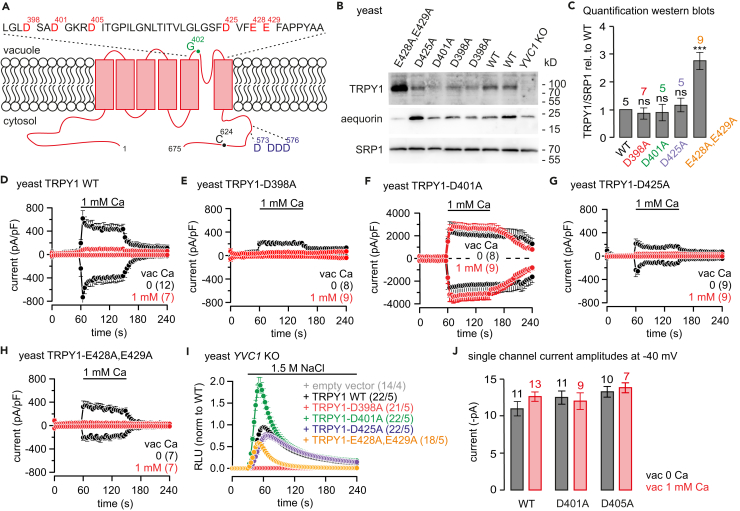
Vacuolar TRPY1 Currents in YVC1 KO Yeast Expressing Wild-Type or Mutant YVC1 cDNAs(A) Predicted transmembrane topology of the yeast vacuolar TRPY1 (675 amino acid residues) with negative charge cluster at the cytosolic C-terminus assumed to be responsible for TRPY1 activation (blue) (Su et al., 2009) and negatively charged residues within the S5-S6 linker facing the vacuolar lumen (red). The TRPY1G402S mutant (green) is constitutively active (Zhou et al., 2007), and the TRPY1C624S mutant (black) can no longer be activated by 2-mercaptoethanol (Hamamoto et al., 2018).(B) Western blot of protein lysates from non-transformed yeast (YVC1 KO) or YVC1 KO yeast transformed with wild-type (WT) and mutant YVC1 cDNAs (as indicated). Filter was stripped and incubated with antibodies for aequorin (middle) and SRP1 (serine-rich protein; bottom) as controls.(C) Antibody stain intensities of TRPY1 proteins in (B) were quantified relative to the antibody stain of the endogenous serine-rich protein 1 (SRP1) and normalized to the WT TRPY1/SRP1 ratio (summary of five independent western blots). One-way analysis of variance (ANOVA): not significant (ns), ∗∗∗ p<0.001 compared to WT.(D–H) Whole-vacuole currents at −80 and 80 mV extracted from 200-ms ramps (0.5 Hz) spanning from 150 to −150 mV, Vh = 0 mV, plotted versus time, activated by cytosolic Ca2+ (1 mM) at 0 (black) or 1 mM (red) vacuolar (vac, patch pipette) Ca2+ in YVC1 KO cells expressing WT ( D) or mutant (E–H) YVC1 cDNAs.(I) Changes of cytosolic Ca2+ challenged by 1.5 M NaCl (hyperosmotic shock) monitored in transformed YVC1 KO yeast cells (as in D–H) as relative luminescence units (RLU). Bars indicate application of 1 mM Ca2+ (D–H) or 1.5 M NaCl (I).(J) Single-channel current amplitudes of TRPY1WT, TRPYD401A, and TRPY1D405A in the absence and presence of vacuolar 1 mM Ca2+, analyzed at −40 mV from current traces of voltage ramps and voltage steps in whole vacuoles and excised (outside-out) vacuolar patches. Single channels of TRPY1D405A were analyzed from yeast cells transfected with single-copy pRS316 CEN plasmids without its own promoter (see Figure S4C). Currents are normalized to the size of the vacuole (pA/pF) and shown as means ± SEM with number of measured vacuoles (D–H) or the number of experiments (x) from y independent transformation (x/y; (I) indicated in brackets. Single-channel current amplitudes in (J) are shown as means ± SEM with number of independent experiments indicated. One-way analysis of variance (ANOVA) revelead no differences.See also Figures S3 and S4.